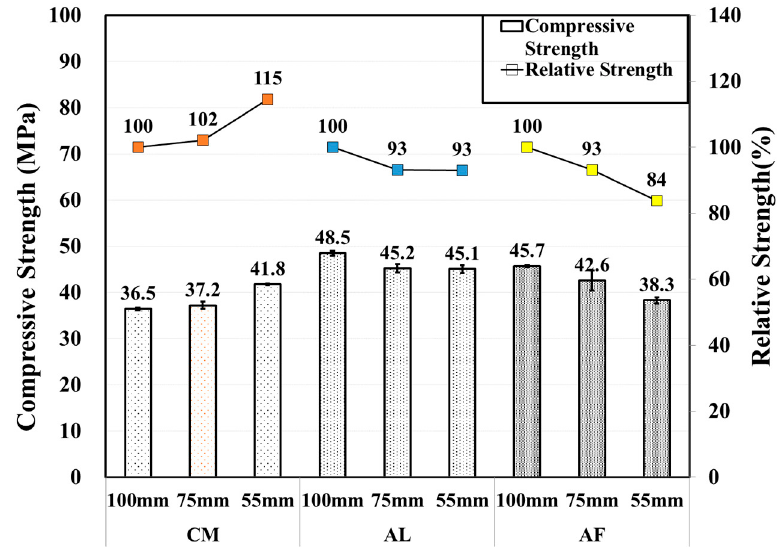
Figure 8. Core compressive and relative strengths of SH specimens by accelerators for 6 month-old specimens.